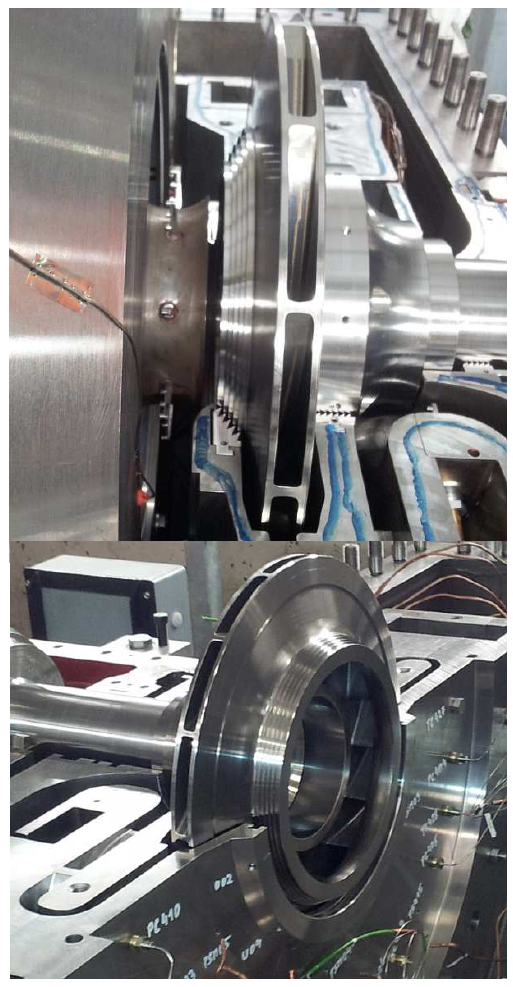
Fig. 3. Models of the stages RTK06W and RTK04N in the test compressor